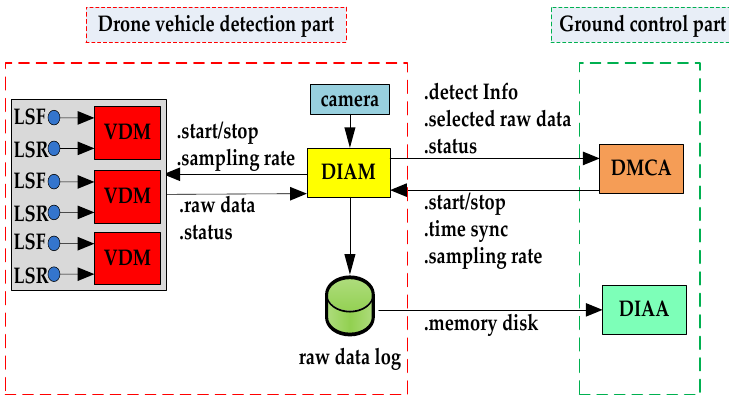
Figure 3. Vehicle information detection system.